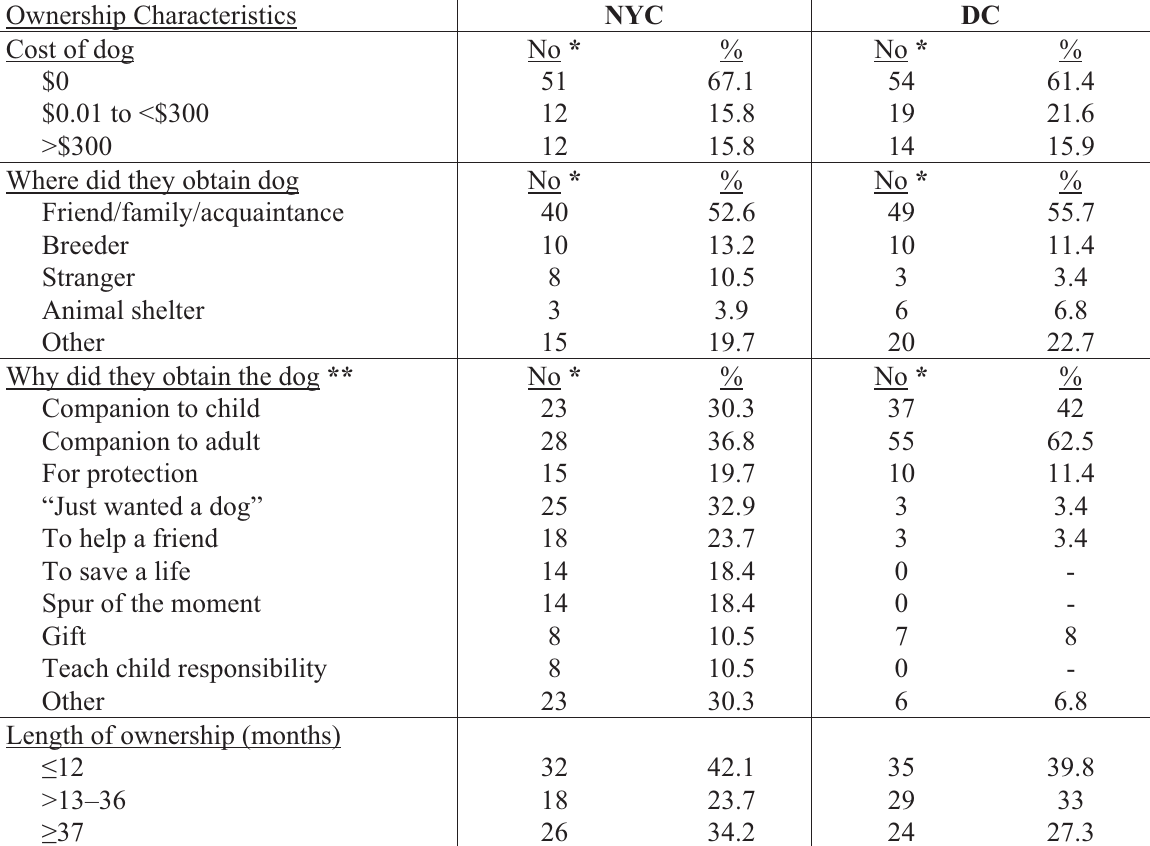
Table 3. Ownership characteristics of large dogs relinquished to a shelter in New York City and Washington,